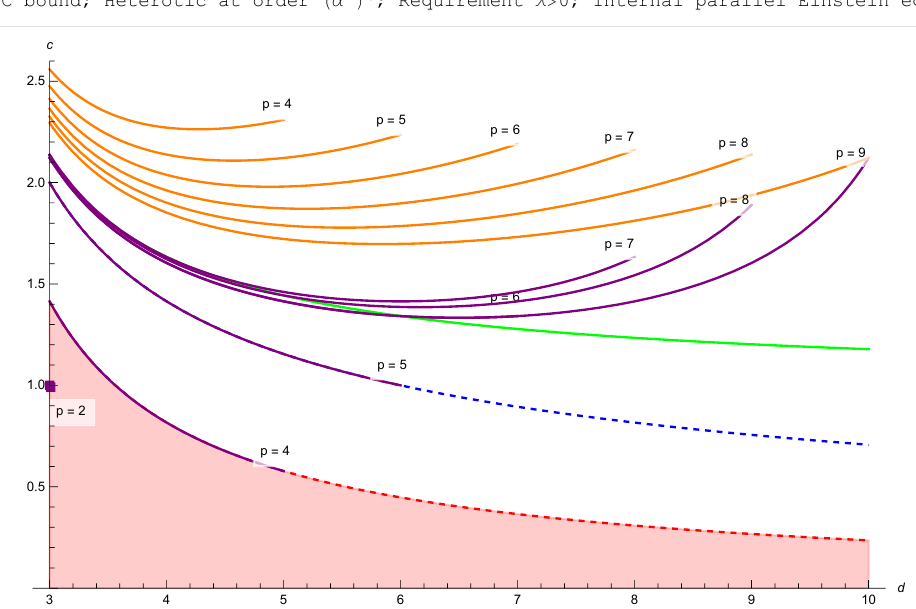
Figure 2 . Graph of the c values in terms of the dimension d , 3 ≤ d ≤ 10 , for each no-go theorem indicated in table 4. They are represented with plain lines of different colors, as made explicit in the caption above. Some values are p -dependent (dimensionality of O ), as indicated on the graph. p /D p The dashed lines represent bounds: the TCC (lower) bound (4.37), with its forbidden region being filled, and the so-called accelerated expansion (upper) bound, discussed in section 5.3. Interestingly, one no-go theorem violates the TCC bound, in d = 3